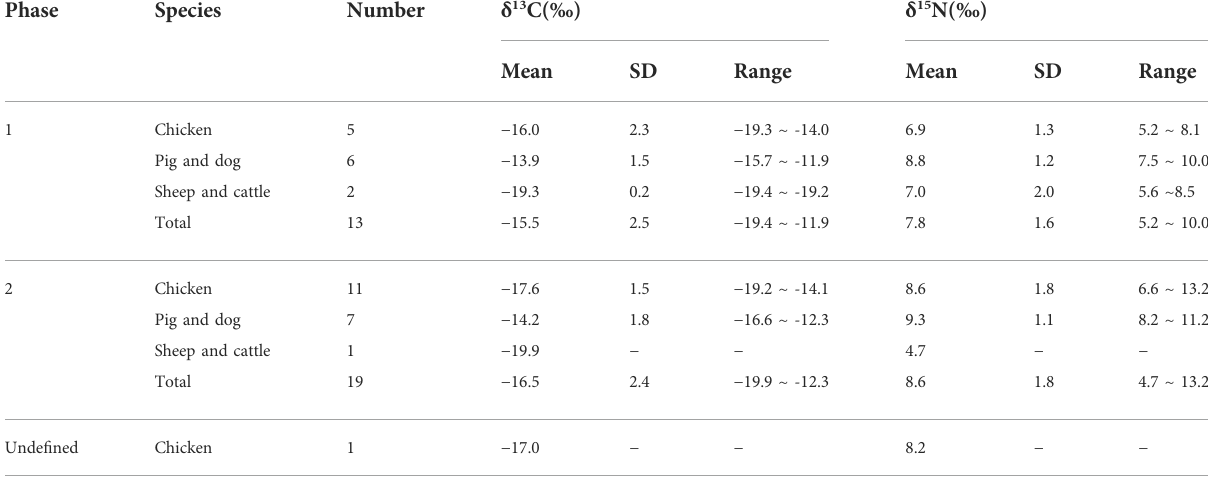
TABLE 2 Summary of carbon and nitrogen isotope results for animal samples.